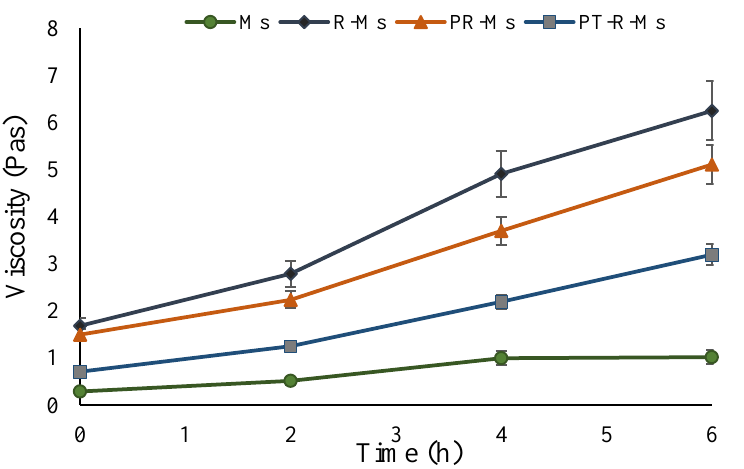
Figure 5. Rheology studies of Ms, R-Ms, P-R-Ms, and PT-R-Ms. Results are expressed as mean ± SD, ( n = 3), p < 0.05.